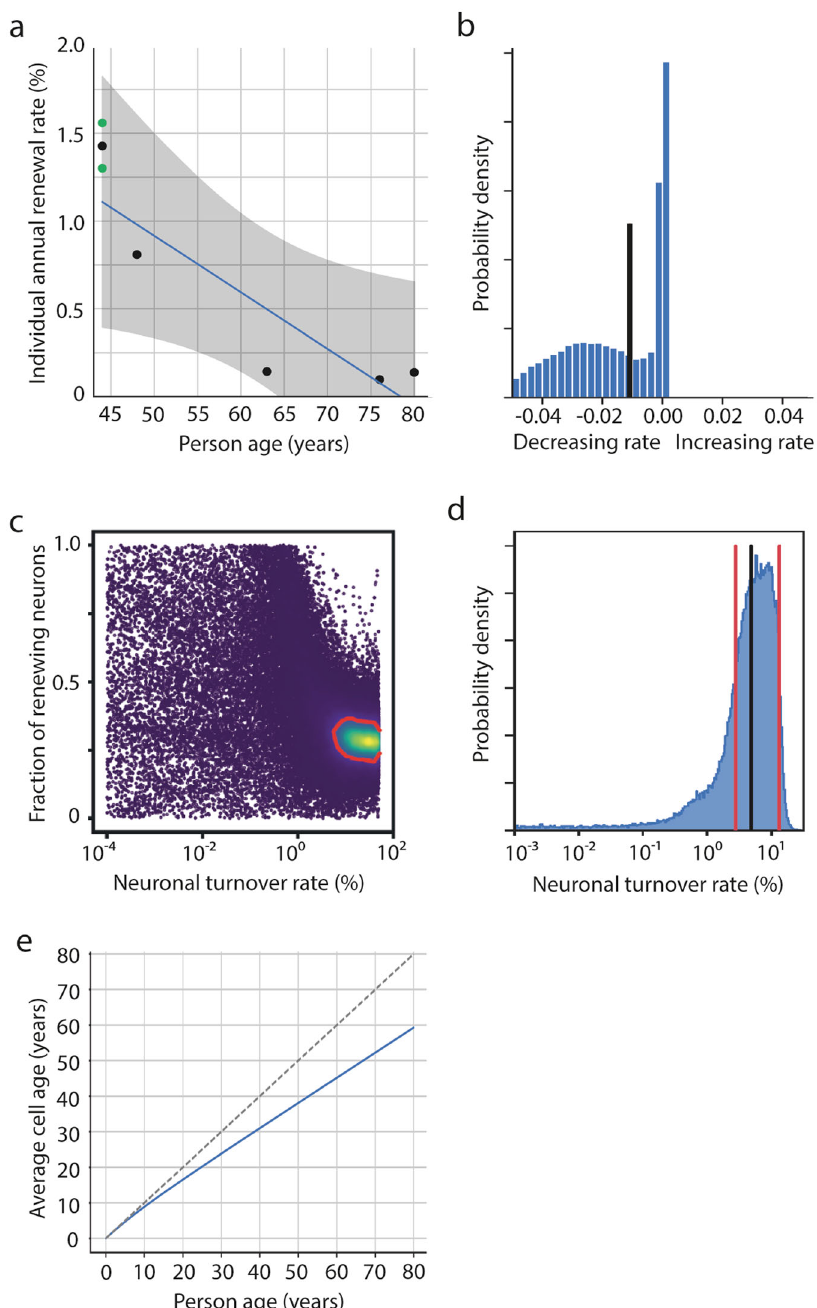
Fig. 3 Dynamics of neuronal cell turnover in the human amygdala. Mathematical modelling of different neuronal cell turnover scenarios. a Scenario A assumes a constant turnover rate of neurons in the human amygdala over the lifetime of the individual. Fitting all samples to the model results in a median turnover rate of 0.2%/year [0.02;1.35]. However, separate fi ts for each sample revealed a negative correlation between age and individual turnover rate ( r = − 0.9, p = 0.083) with an annual decline in turnover of − 0.03%/year. Green dots are amygdala measurements from both hemispheres from the same individual. Mean of these two dots are shown as black dot in between. b Scenario LIN, assuming a linear decline in cell turnover with age, revealed a median annual change in turnover rate (black vertical line) of − 1 %/year [ − 4;0.08]. c Markov-Chain-Monte Carlo sampling for neuronal turnover for scenario 2POP, which assumes a quiescent and a renewing neuronal population, showing a two-dimensional marginal posterior distribution for turnover rate and fraction of renewing cells; blue: low probability, yellow: high probability, 1-sigma con fi dence region is framed by a red line. d Marginal posterior distribution for the estimated turnover rate calculated to the entire neuronal population, which is the product of the renewing rate of the renewing fraction, and the fraction of renewing cells, based on scenario POP2. Vertical red lines indicate lower and upper estimates (one sigma) of neuronal turnover. Black vertical line indicates median of turnover. e Age of amygdaloid neurons in relation to subject age based on the lower turnover limit of scenario 2POP. The bisecting (dashed) line represents a no-turnover-scenario in which every cell is as old as the individual, the blue line progressively de fl ects from the bisector with increasing subject age, re fl ecting lifelong post-natal neuronal cell